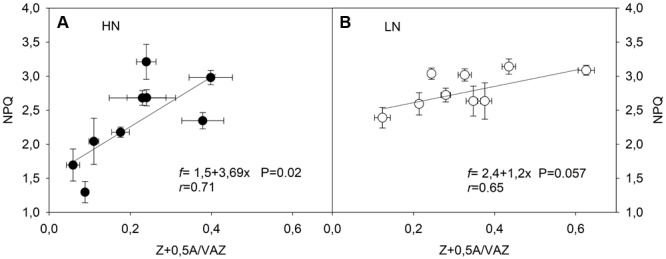
Relationship between the de-epoxidation state of xanthophyll pool (DEPS) and non-photochemical quenching (NPQ) at HN (A) and LN (B) supplementation in three genotypes of C. quinoa. The pigments analyses and NPQ determinations were performed in fully expanded leaves (third leaf from the top) from plants subjected to all treatments and times. Values were calculated as mean values ± SE from four independent plants. Linear Pearson’s correlation coefficient (r) was used to examine the correlations. Kolmogorov–Smirnov and Lilliefors test was used for normality analysis.